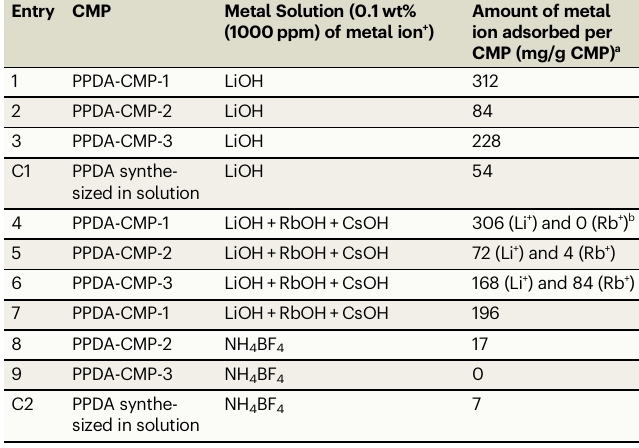
Table 2 | Adsorption of metal ions by PPDA-CMP-1, 2, and 3 and PPDA synthesized in solution phase Entry